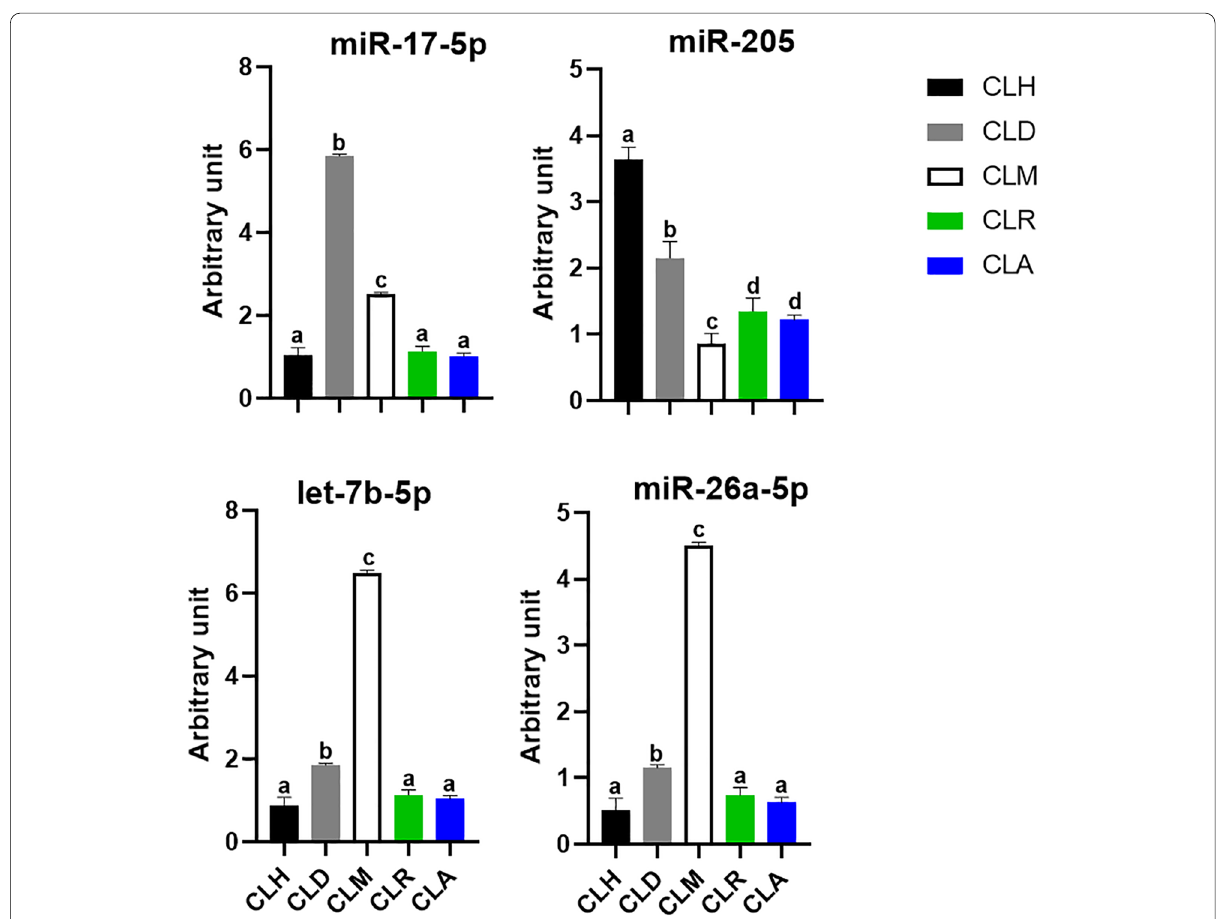
Fig. 2 Relative abundance of miR‑17‑5p, miR‑205, let-7b-5p , and miR‑26a‑5p at different stages of corpus luteum in Egyptian buffaloes. Bars are presented as mean SEM. a,b,c,d Statistical differences between different stages of CL: hemorrhagic (CLH), developing (CLD), mature (CLM), regressed ± (CLR), and albicans